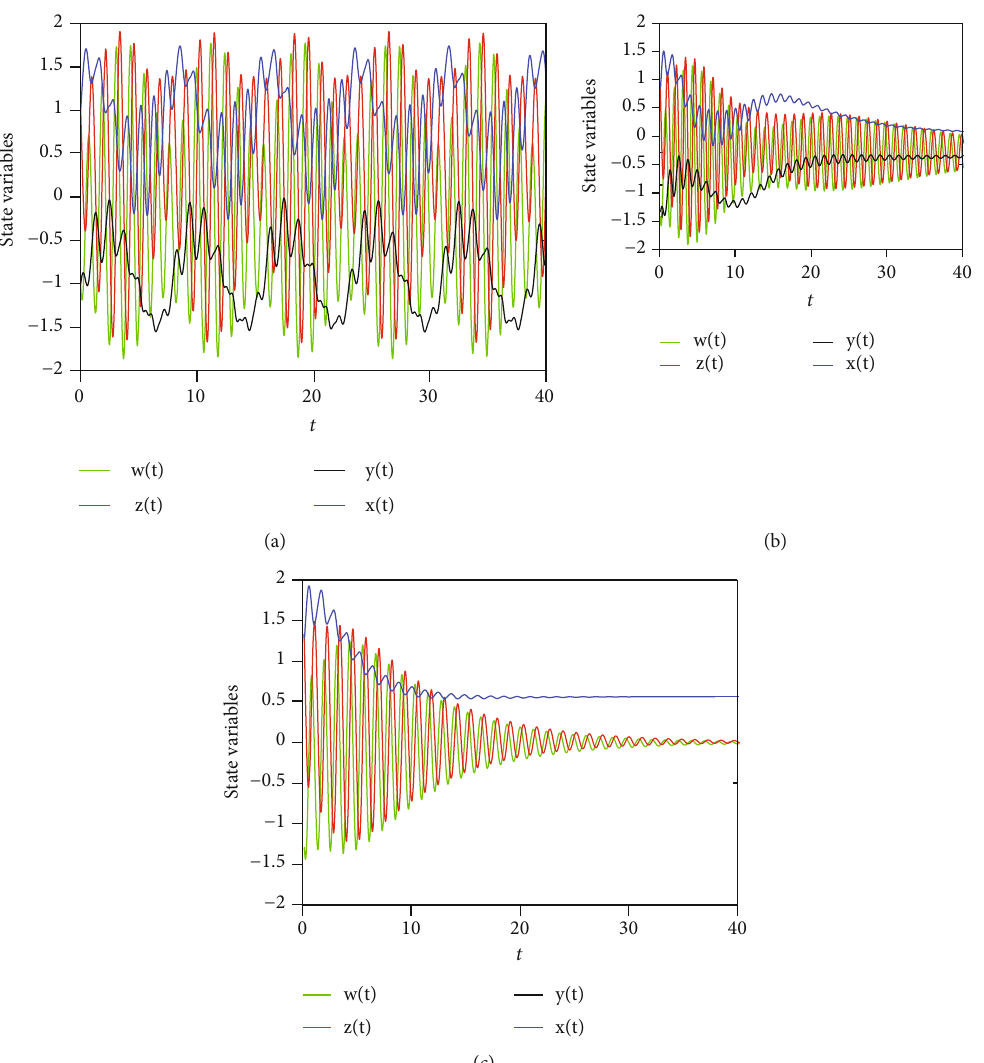
Figure 17: The time-series behavior of di ff erent state variables of system 1 with fractional order ϖ = 0 : 98 and the parameters c = 2, d = 5